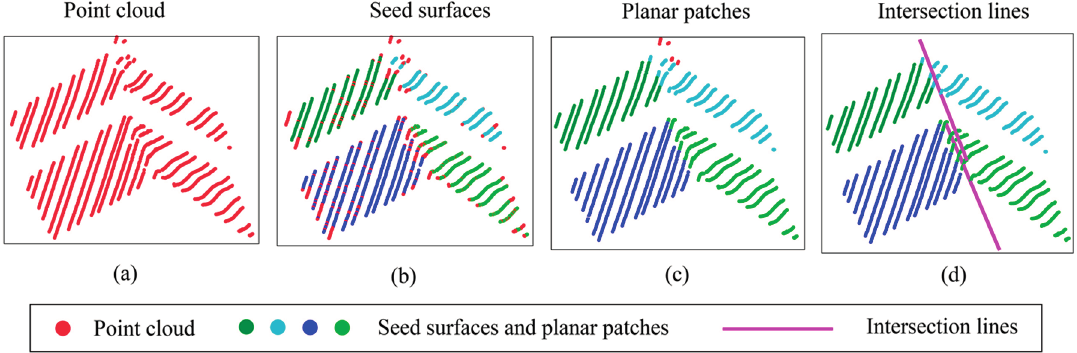
Figure 3. Procedure of plane